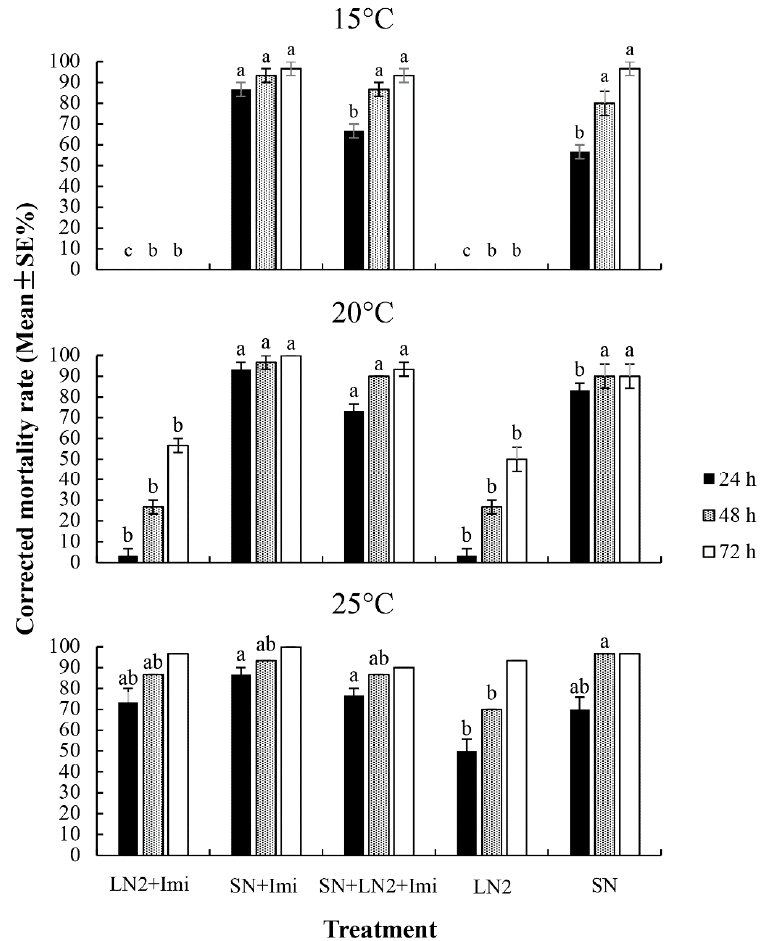
Figure 3. The corrected mortality rates of the Bradysia odoriphaga larvae treated with entomopathogenic nematodes (EPN) and EPN–imidacloprid combinations for 24, 48, and 72 h. LN2: LN2 applied at 3.0 × 10 9 IJ · ha − 1 ; SN: Steinernema feltiae SN applied at 3.0 × 10 9 IJ · ha − 1 ; Imi: imidacloprid Heterorhabditis indica LN2 applied at 3.0 × 10 9 IJ·ha − 1 ; SN: Steinernema feltiae SN applied at 3.0 × 10 9 at 1 / 10 recommended field rate (4.5 g · ha − 1 ); SN + LN2: both H. indica LN2 and S. feltiae SN applied at IJ·ha − 1 ; Imi: imidacloprid at 1/10 recommended field rate (4.5 g·ha − 1 ); SN + LN2: both H. indica LN2 1.5 × 10 9 IJ · ha − 1 . Bars with the same letter do not di ff er significantly at the same checking time ( p <